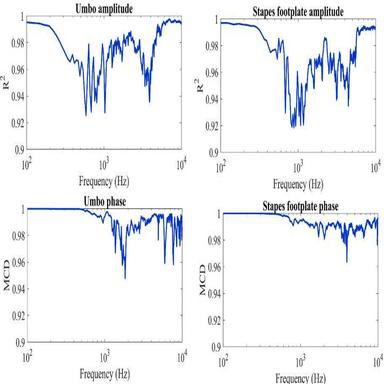
Values of R2 (for the amplitude) and MCD (for the phase) of the umbo and stapes footplate in the frequency range of 100 Hz to 10 kHz. The values of R2 and MCD are calculated based on the predictions of the ML models for the whole testing dataset (with the size of 100). For both amplitudes of the umbo and stapes footplate amplitudes, the value of R2 is very close to 1 at very frequencies below 200 Hz and frequencies above 6 kHz. The minimum values of R2 for the amplitude of the umbo and stapes footplate are